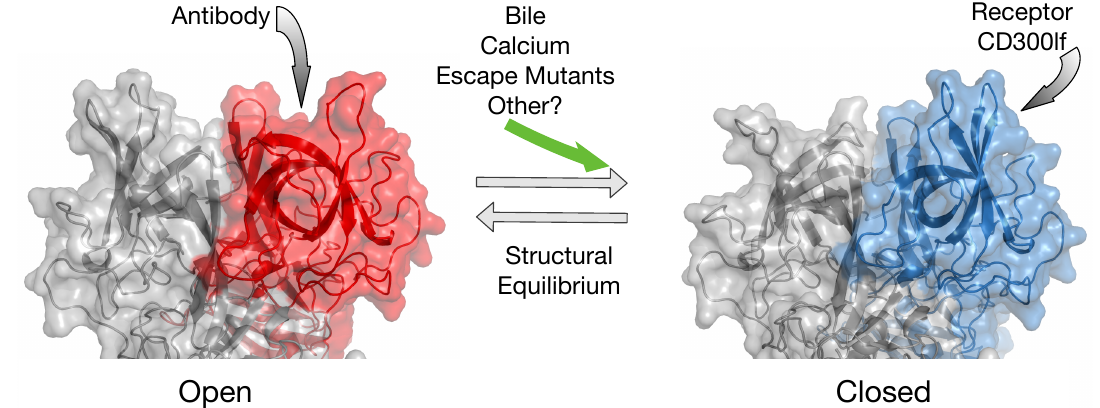
Figure 9. Model for intrinsic conformational dynamics within the P domain. In this highly simplistic overview, there are at least two conformation for the P domain; open (red) and closed (blue). The antibodies to date that neutralize MNV appear to only bind to the open conformation while the receptor appears to prefer binding to the closed conformation. From the results reviewed here, it appears that the structural equilibrium is shifted towards the receptor-binding closed state by some of the “allosteric” antibody escape mutations and by external stimuli such as bile salts and metals like